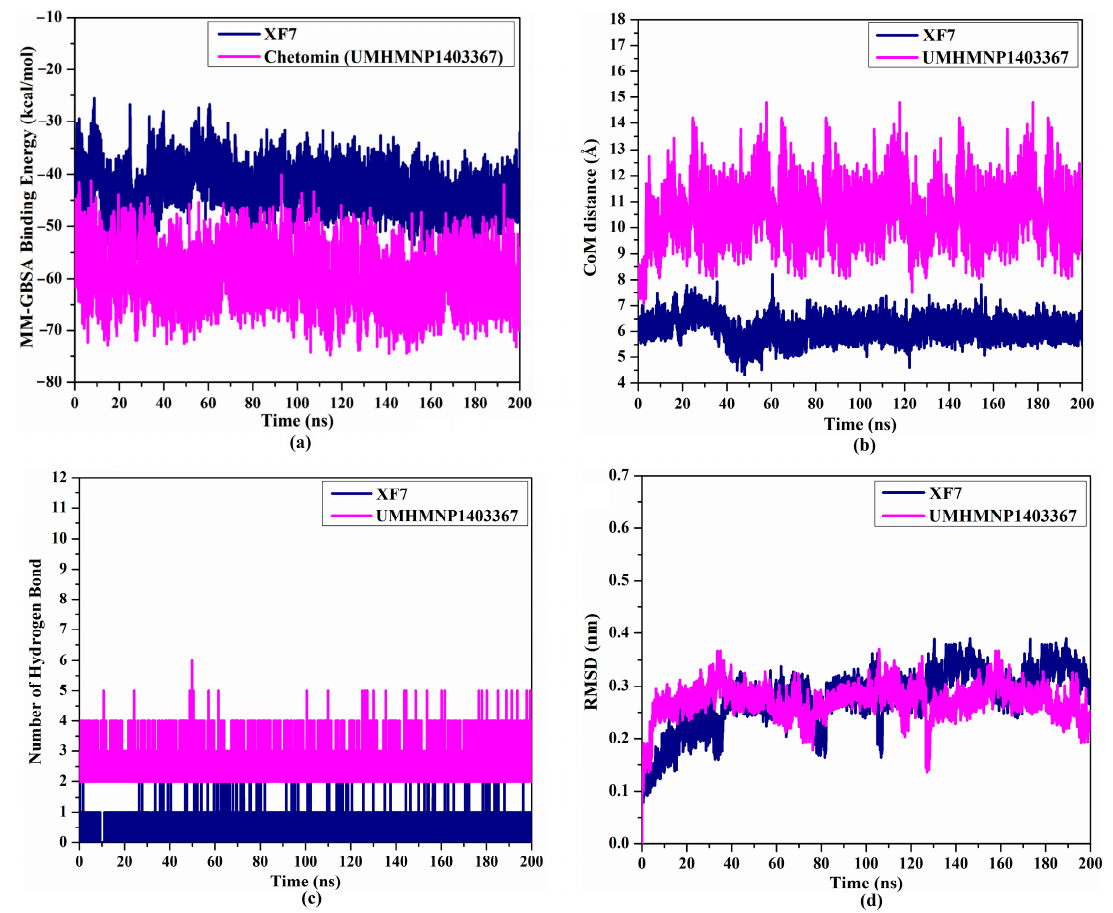
Figure 7. ( a ) Estimated binding energy per frame, ( b ) center-of-mass (CoM) distance, ( c ) the number of H-bonds, and ( d ) root-mean-square deviation (RMSD) of the backbone atoms from the starting structure of chetomin (pink) and XF7 (navy) towards the 3CL pro throughout 200 ns MD.